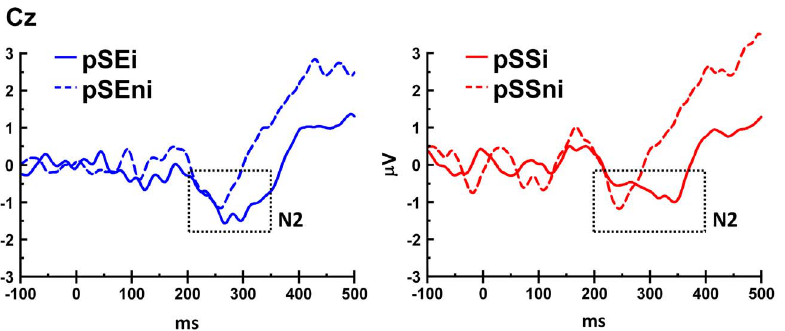
Figure 2. ERP curves during post-stop trials at Cz channel, time-locked to go-signal onset (at 0 ms). Paired signed-rank tests showed that the mean amplitude of N2 was greater in pSEi than pSEni trials (left column), but not greater for pSSi than pSSni trials (right column). On the other hand, signed-rank test showed that the peak latency of N2 was longer in pSSi than pSSni trials, but not longer for pSEi than pSEni trials. These results suggest that increased N2 amplitude was specifically related to post-error slowing, and increased N2 latency was related to post-conflict